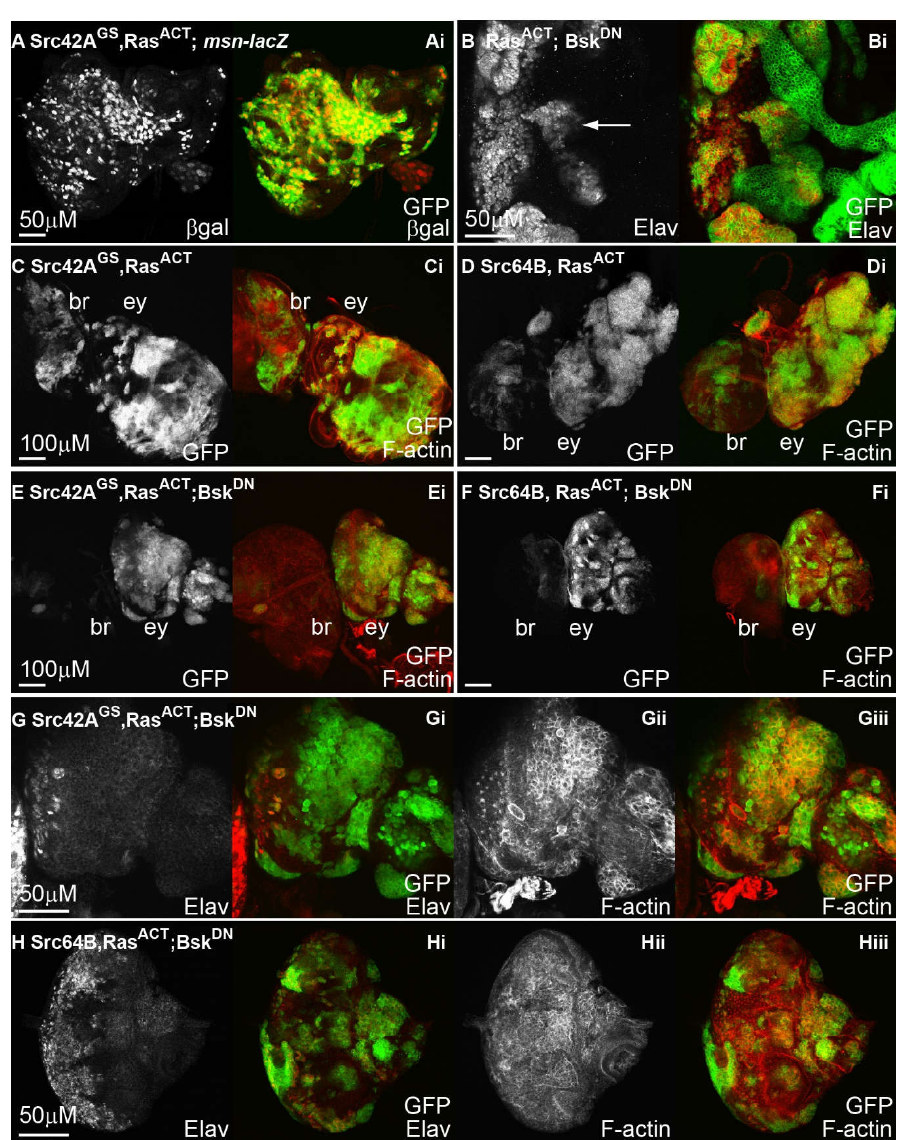
Figure 7. JNK pathway is activated in Src + Ras ACT eye disc clones, and blocking JNK signalling in Src + Ras ACT clones suppresses clonal tissue overgrowth and restores differentiation. Confocal images, planar views, of eye‐antennal discs. Clones are marked by expression of GFP (green in merged images). βgal antibody detection measures transcription of the msn-lacZ enhancer trap (red in merged images). Elav marks differentiated cells (in B , G , H as marked, red in merged images, i ) and rhodamine‐phalloidin visualises F‐actin to mark cell outlines (in C – H as marked, red in merged images, Ci – Fi and Giii , Hiii ). ( A ) Scale bar, 50 μM; ( B – F ) Scale bar, 100 μM; and ( G , H ) Scale bar, 50 μM. Genotypes: ( A ) Src42A GS , Ras ACT ; msn-lacZ : ey-FLP1 , UAS-mCD8-GFP/+; GS11049 , UAS-Ras ACT /+; tub-GAL4 FRT82B tub-GAL80/msn-lacZ FRT82B ; ( B ) Ras ACT ; Bsk DN : ey-FLP1 , UAS-mCD8-GFP/+; UAS-Ras ACT /+; tub-GAL4 FRT82B tub-GAL80/FRT82B UAS-bsk DN ; ( C ) Src42A GS , Ras ACT : ey-FLP1 , UAS-mCD8-GFP/+; GS11049 , UAS-Ras ACT /+; tub-GAL4 FRT82B tub-GAL80/FRT82B ; ( D ) Src64B, Ras ACT : ey-FLP1 , UAS-mCD8-GFP/+; UAS-Src64B , UAS-Ras ACT /+; tub-GAL4 FRT82B tub-GAL80/FRT82B ; ( E , G ) Src42A GS , Ras ACT ; Bsk DN : ey-FLP1 , UAS-mCD8-GFP/+; GS11049 , UAS-Ras ACT /+; tub-GAL4 FRT82B tub-GAL80/FRT82B UAS-bsk DN ; and ( F , H ) Src64B, Ras ACT ; Bsk DN : ey-FLP1 , UAS-mCD8-GFP/+; UAS-Src64B , UAS-Ras ACT /+; tub-GAL4 FRT82B tub-GAL80/FRT82B UAS-bsk DN . Src42A GS + Ras ACT clones show upregulation of the msn-lacZ reporter ( A ). Expression of Ras ACT + bsk DN in clones ( B ) resulted in ectopic differentiation anterior to the morphogenetic furrow (white arrow, B ), comparable to that of expression of Ras ACT alone (Figure 2C). Expression of Src42A GS + Ras ACT ( C ) or Src64B + Ras ACT ( D ) in mosaic eye discs resulted in tissue overgrowth with indistinguishable eye or antennal